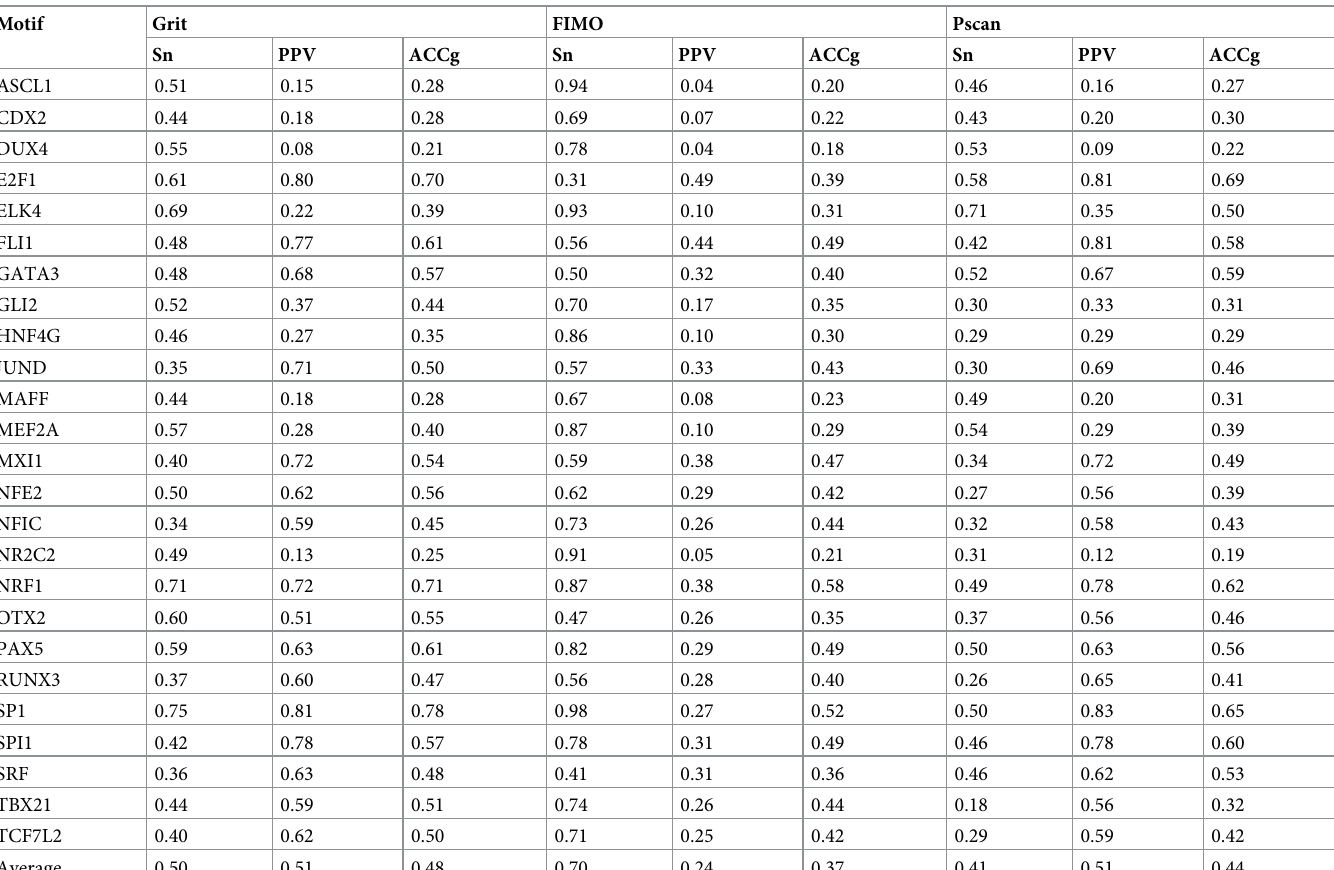
Table 2. Performances of Grit with FIMO using publicly available Chip-seq datasets with literature